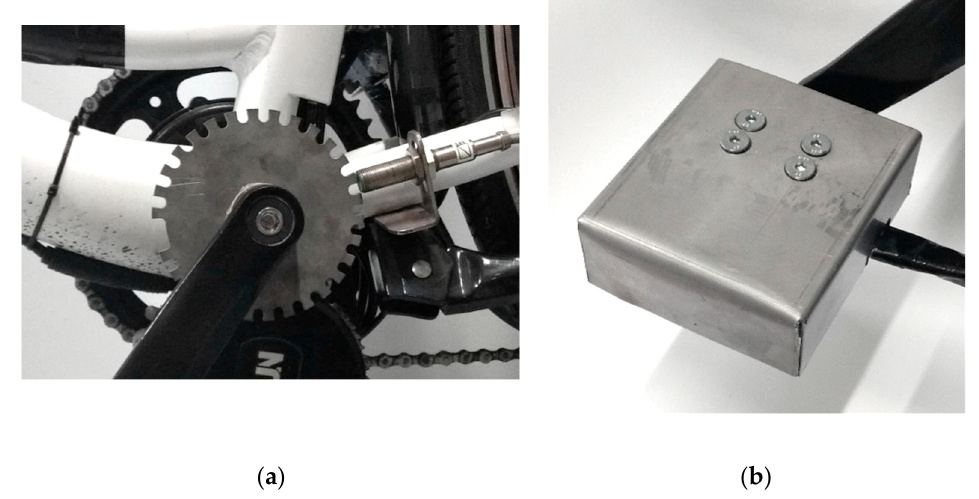
Figure 1. From left to right ( a ) unique encoder, ( b ) instrumented pedal.